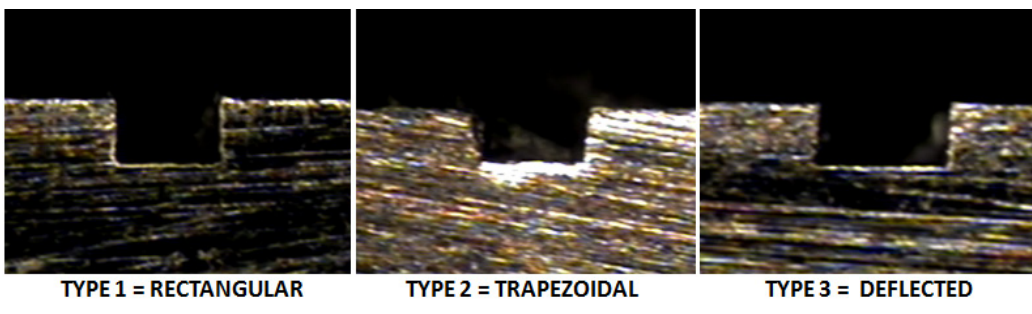
Figure 22. Common categorized profiles in Ti